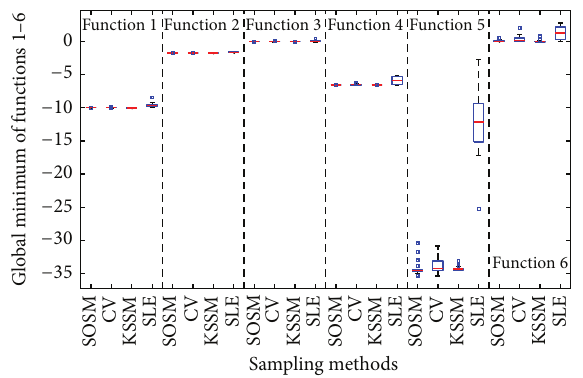
Figure 19: Assessment of metamodels: global minimum between SOSM and previous sequential sampling methods.